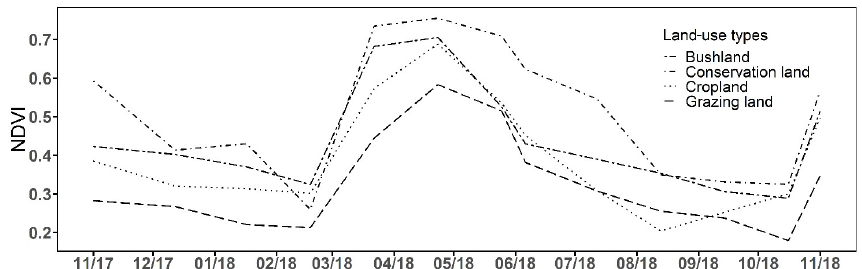
Figure 6. Monthly NDVI time series showing the annual trend in vegetation cover from November 2017 to November 2018 for the four land-use types. (See Fig. S1 in the Supplement for the change in the normalized difference vegetation index (NDVI) during each campaign.)